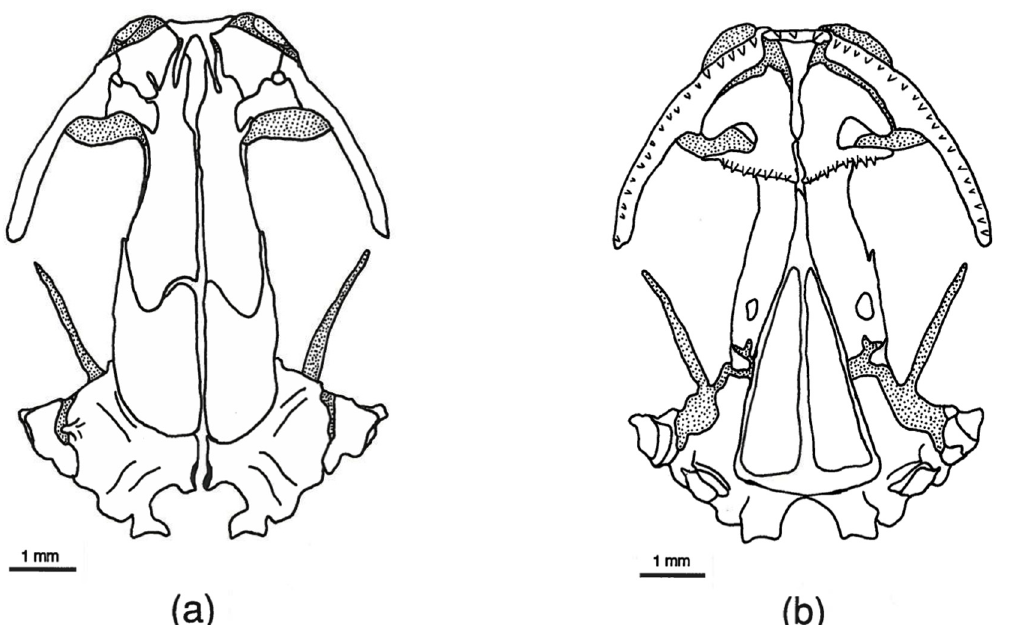
Fig 3. Chiropterotriton priscus skull. Drawings of dorsal (a) and ventral (b) aspects of the skull of Chiropterotriton priscus (MVZ 163887). Stippled areas represent cartilage. Elements as labeled in Fig 1.